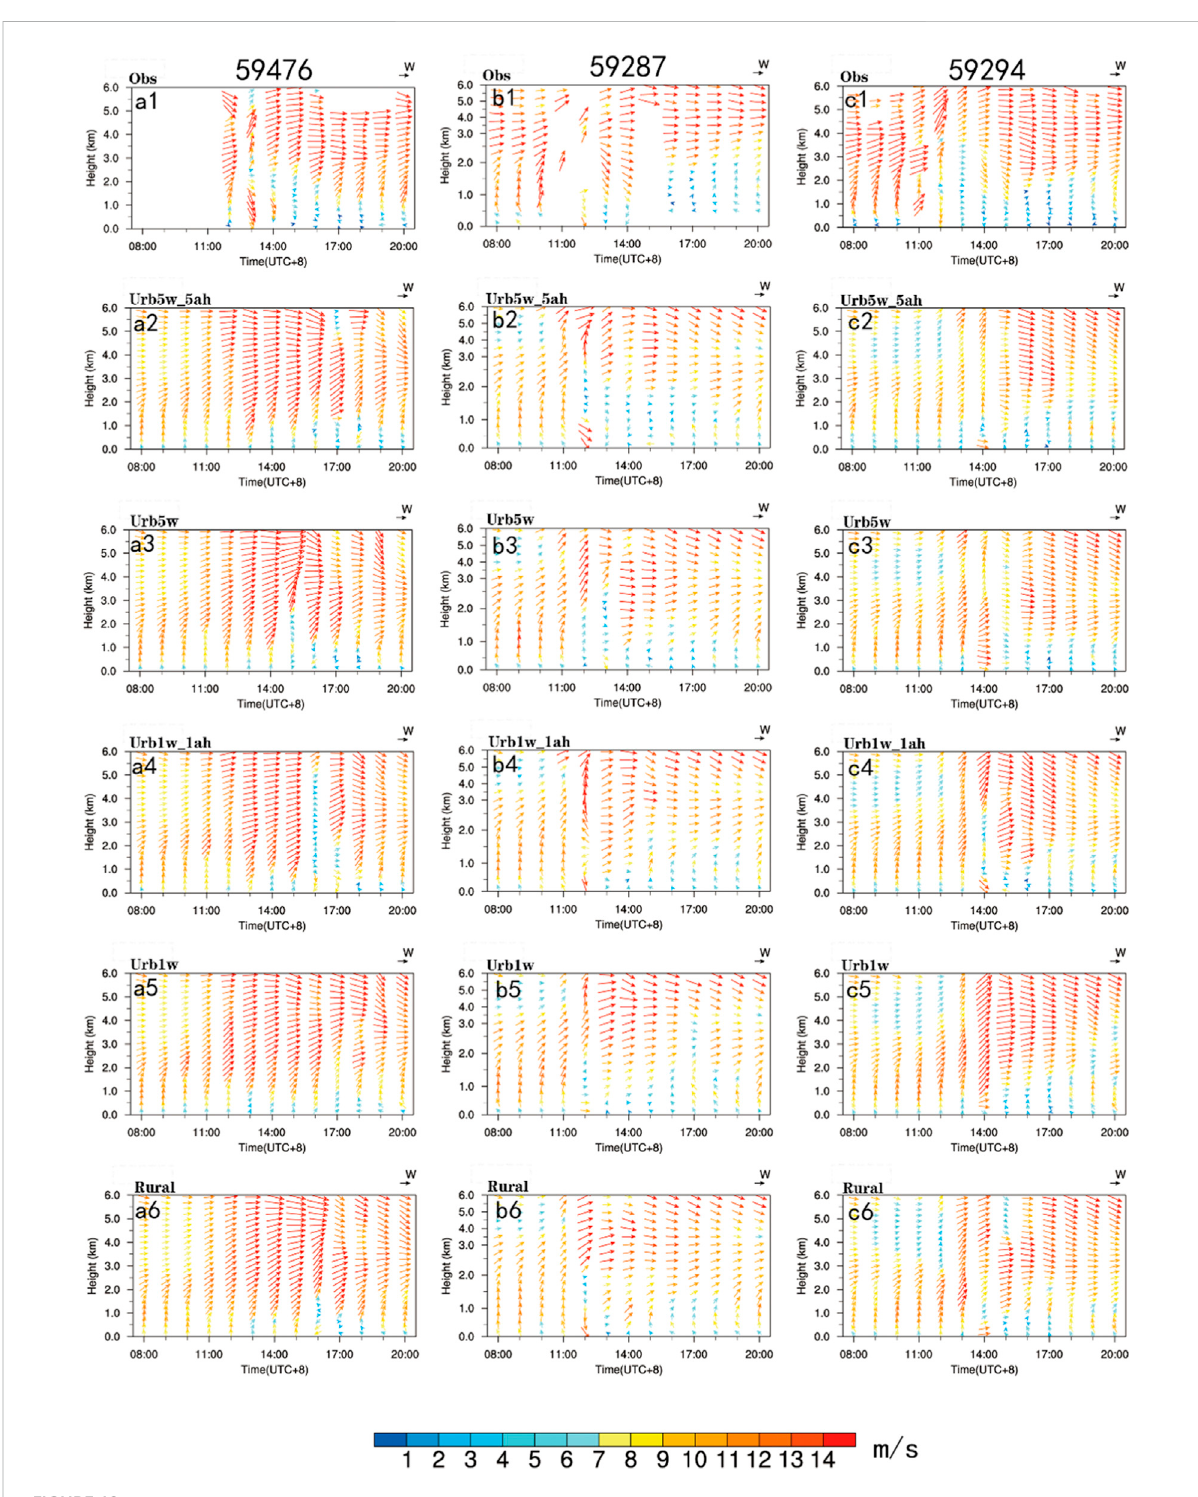
FIGURE 12 Time – heightsectionsofhorizontalwinddirection(arrows)andwindspeed(colorshading)from0,800to2000LST20Aprilat (A) XinhuiStation, (B) Luogang Station, and (C) Zengcheng